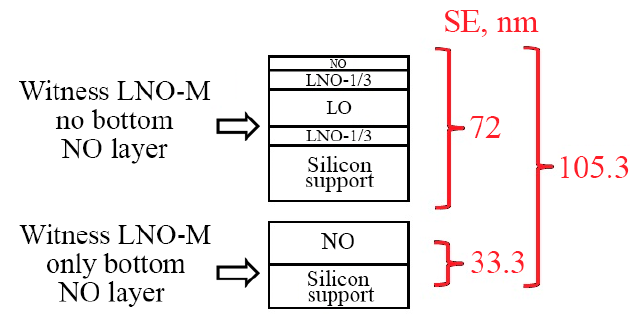
Figure 7. Results of spectral ellipsometry (SE) for LNO-M witnesses.